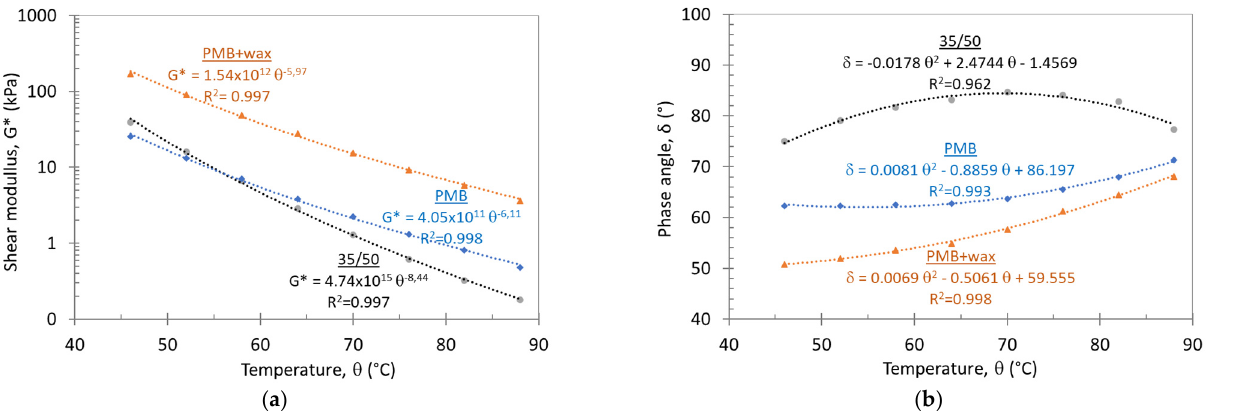
Figure 11. Rheological properties of bituminous binders: ( a ) complex shear modulus (G*); ( b ) phase angle ( δ ).